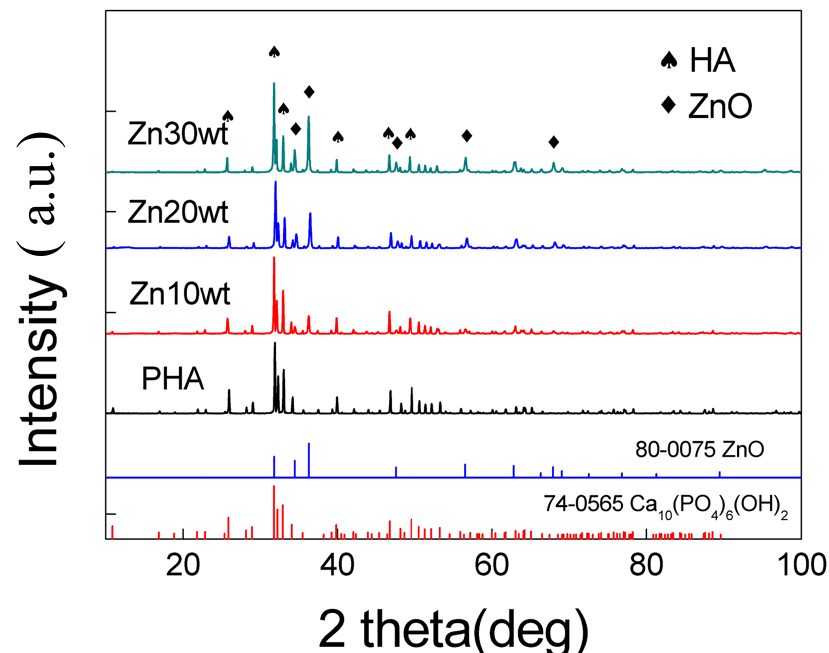
Figure 3. XRD patterns of the ZnO/HA composites.